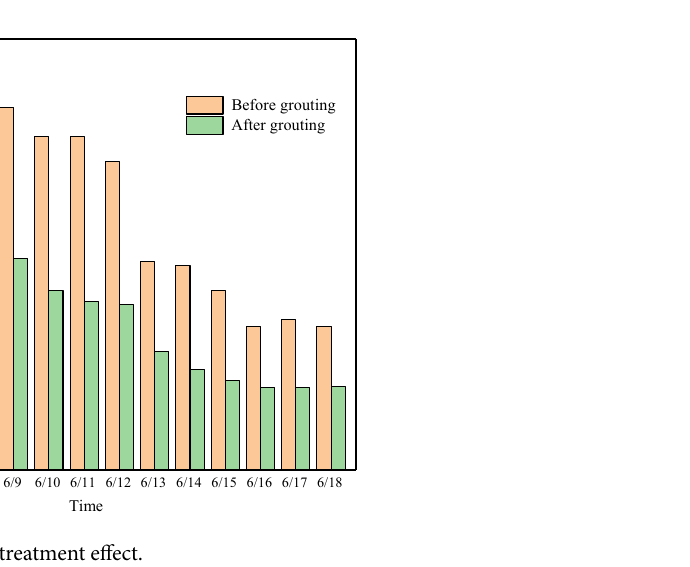
degree. Figure 18 shows that grouting promotes the development of cracks more gently, and the width of cracks is significantly reduced, which can effectively control mining damage. 3. Zoning treatment ground fissures method. For the permanent ground fissures in the mining boundary, the control method of source reduction damage and reinforcement of the key strata is adopted. For the dynamic ground fissures in the middle, the fissures that can be closed are allowed to self-repair. For the fissures that cannot be closed, the method of artificial landfill is adopted. Figure 19 shows the comparison before and after the treatment of mining induced ground fissures.